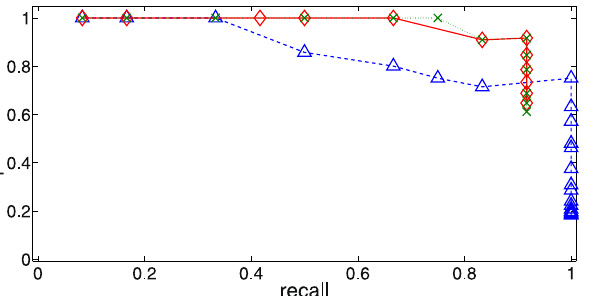
Figure 3. Representative precision/recall curves: Thresholding of MI matrix alone, and not using any maximum entropy method (blue triangles and dashed line); thresholding of CMI matrix obtained using our maximum entropy method on the (unthresholded) mutual informations (green Xs and dotted line); thresholding of mutual informations, and then using the maximum entropy method (red diamonds and solid